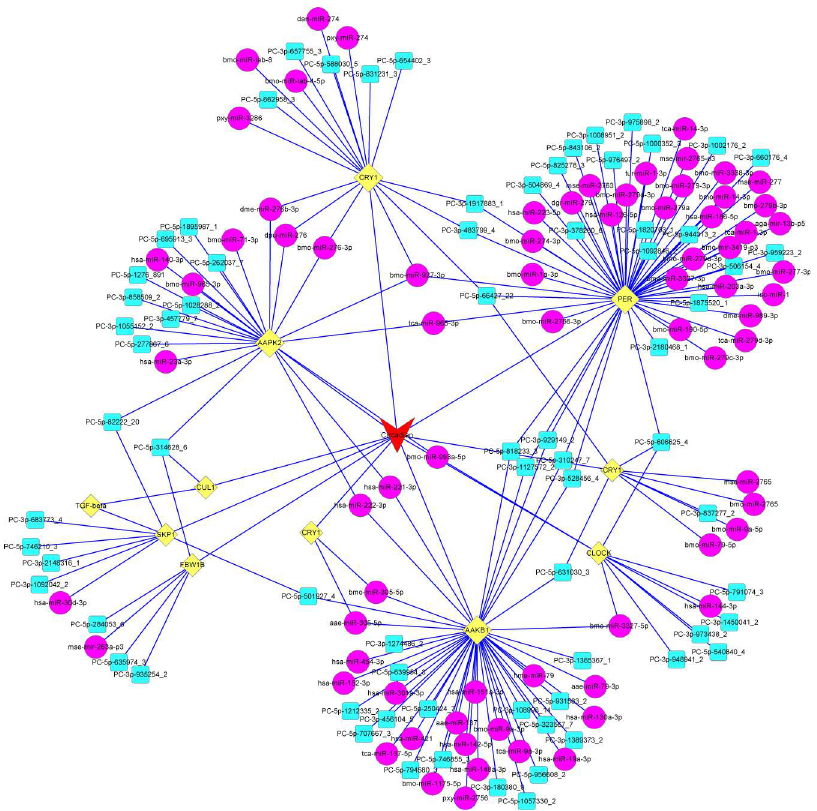
Fig 5. Network prediction of the circadian rhythm pathway in G . molesta . The miRNAs in magenta and cyan circles respectivelyrepresentthe conservedand novel miRNAs. Genes in yellow diamondsare clock genesand those involvedin growth and development regulation.The regulatorynetwork of miRNAs and their target genesfor the circadianrhythm in G . molesta are linkedwith blue lines.